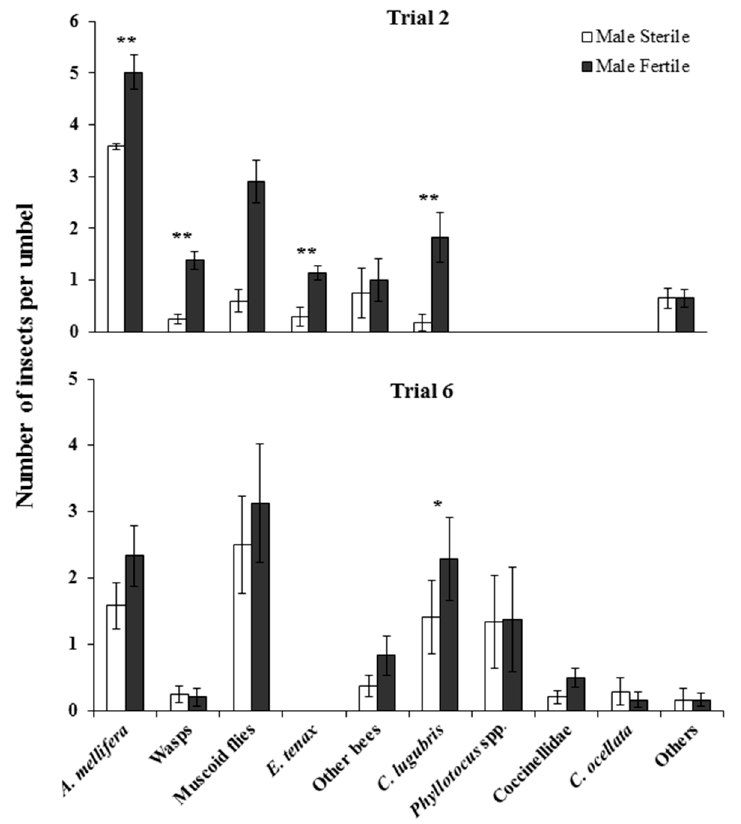
Figure 5. Mean ± SE number of insects observed visiting male-fertile (MF) and cytoplasmically male-sterile carrot (CMS) inflorescences in ( a ) trial 2 and ( b ) trial 6. Trial 2 from left to right n = 132, 29, 29, 7, 4, 6, and 17; trial 6 from left to right n = 22, 5, 22, 11, 15, 7, 10, 3, and 3. ** Indicates significant difference at p < 0.001, * indicates significant difference at p < 0.05.